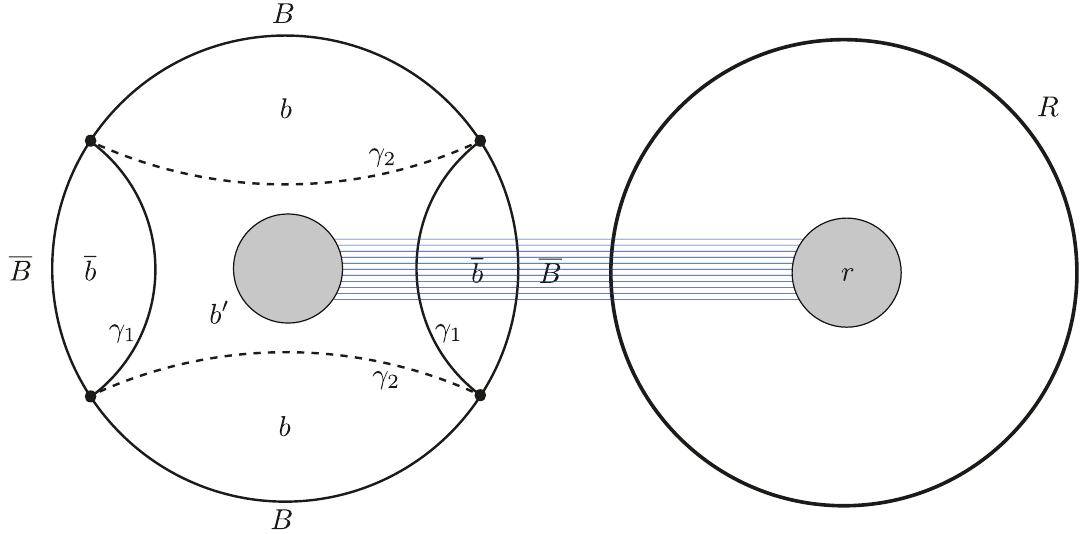
Figure 3 . Two entangled dustballs. Like figure 1, but now we consider the entropy of BR , where R is an entire extra copy of the boundary, dual to its own dustball. The two dustballs are in a mixture of entangled states, given by (2.1). A naïve application of the QES prescription gives the wrong answer for the entropy S ( BR )